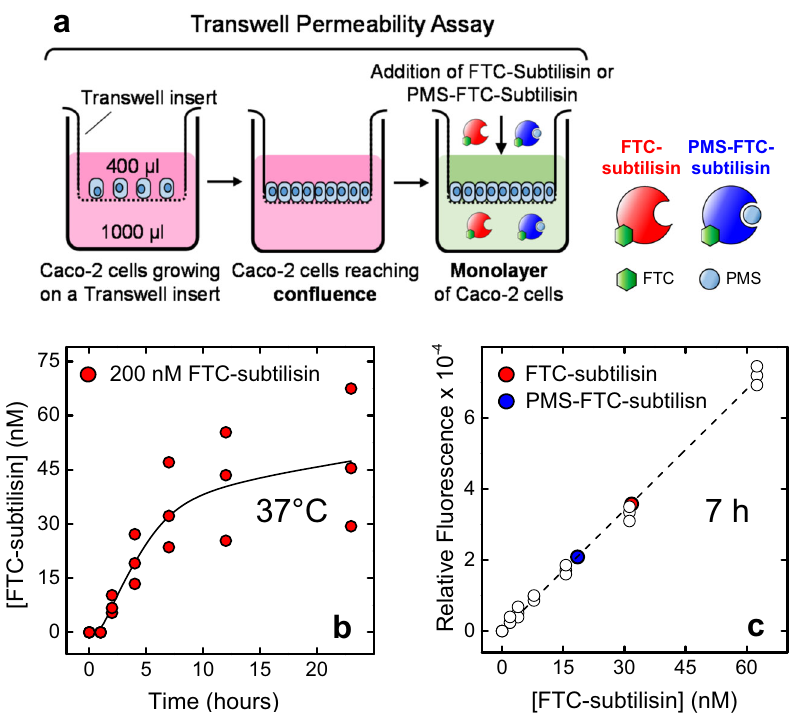
Fig. 9 Caco-2 cells permeability assay of fl uoresceinated subtilisin. a Schematic representation of Caco-2 cells permeability assay. Monolayers of Caco-2 cells on the Transwell permeable inserts were prepared as detailed in the “ Methods ” section. Subtilisin translocation was assessed at 37 °C by adding catalytically active FTC-subtilisin or inactive PMS-FTC-subtilisin (0.2 µ M, 400 µ l), in 10 mM 2-[4-(2-hydroxyethyl)piperazin-1-yl]ethanesulfonic acid, pH 7.4, 10 mM glucose, on the apical chamber and measuring the intensity of fl uorescein emission in the basolateral chamber at increasing translocation times. Blank experiments were carried out in the absence of subtilisin. b Translocation kinetics of FTC-subtilisin (red circles) across Caco-2 monolayers. c The concentration of translocated labeled subtilisin was determined using a calibration curve obtained with known concentrations of labeled enzyme (withe circles). Red and blue circles refer to the concentration of FTC-subtilisin and PMS-FTC-subtilisin, respectively, found in the basolateral chamber of the Transwell apparatus after 7-h translocation. Samples were excited at 488 nm and the fl uorescence intensity was measured at 535 nm, after baseline subtraction. The data points are the results of three different